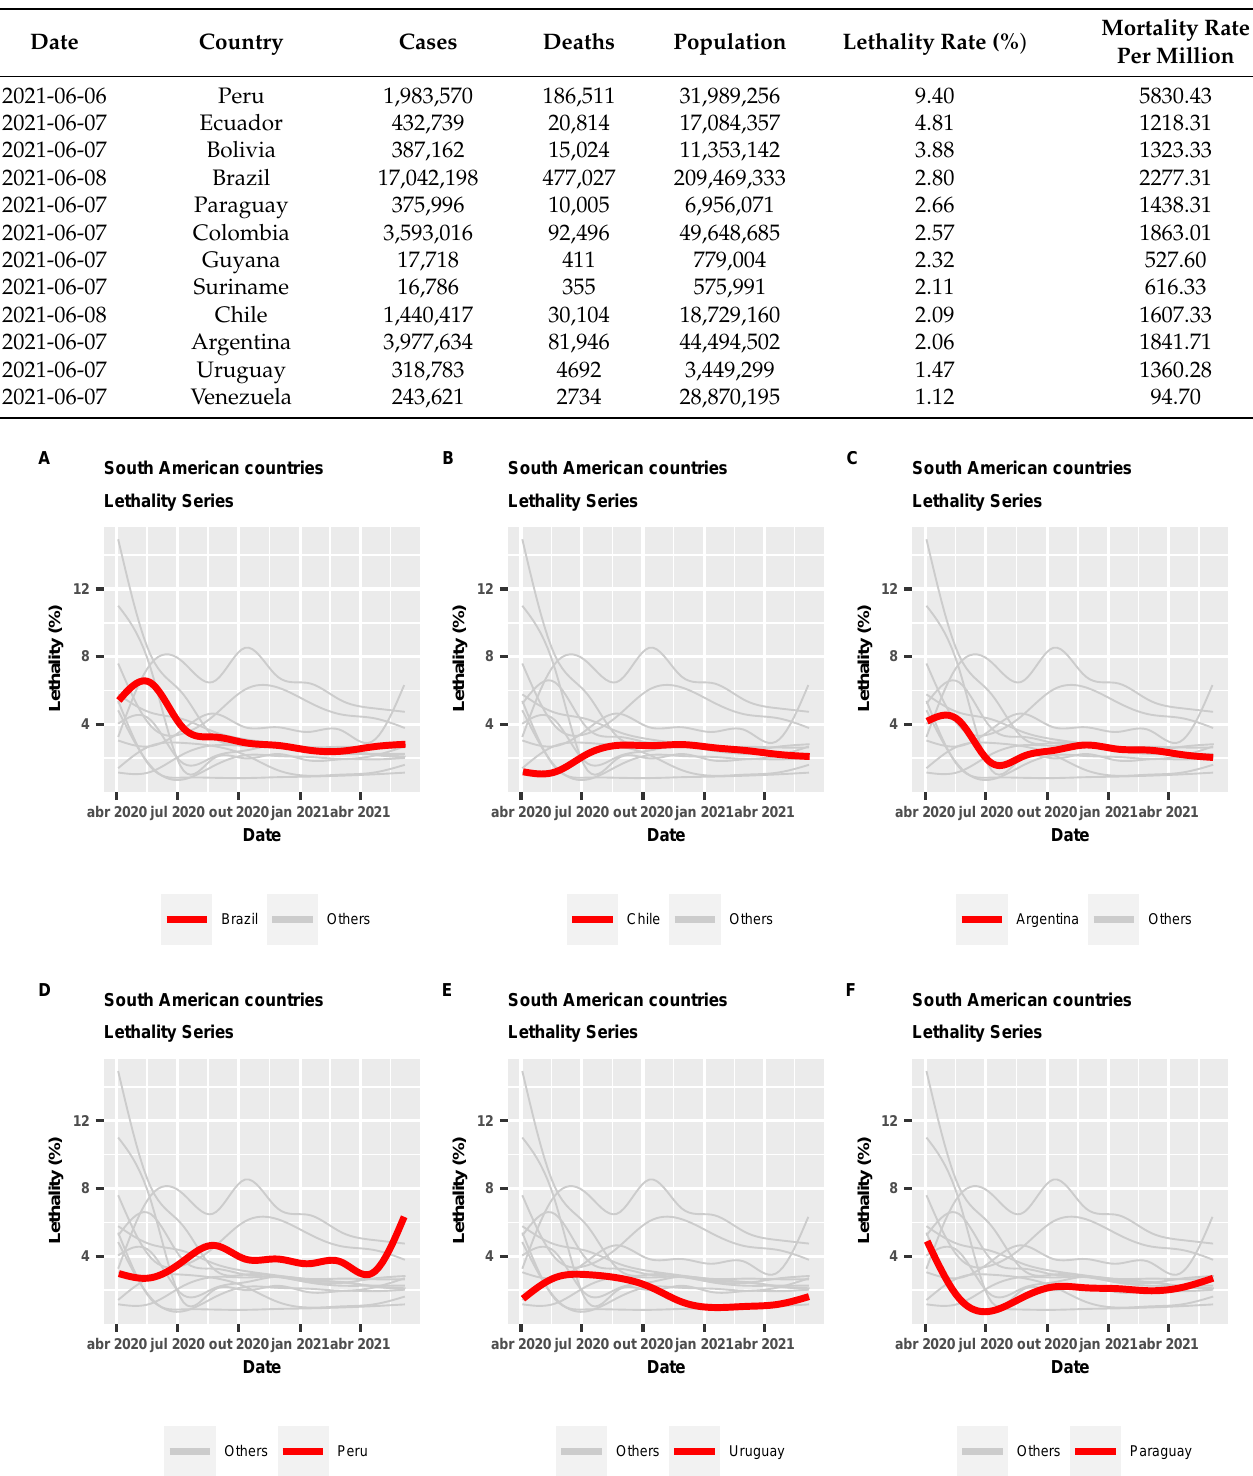
Table 3. COVID-19 statistics by countries in South America.